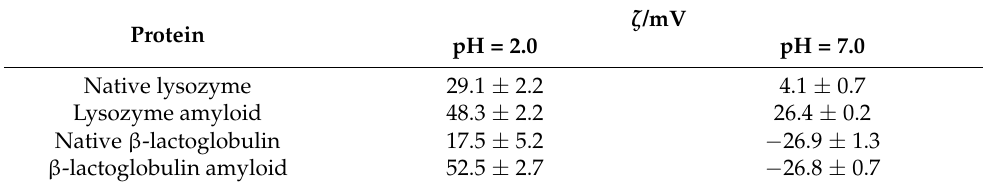
Table 1. Zeta-potential ( ζ ) of lysozyme and β -lactoglobulin as well as its amyloid forms determined at pH 2 and pH